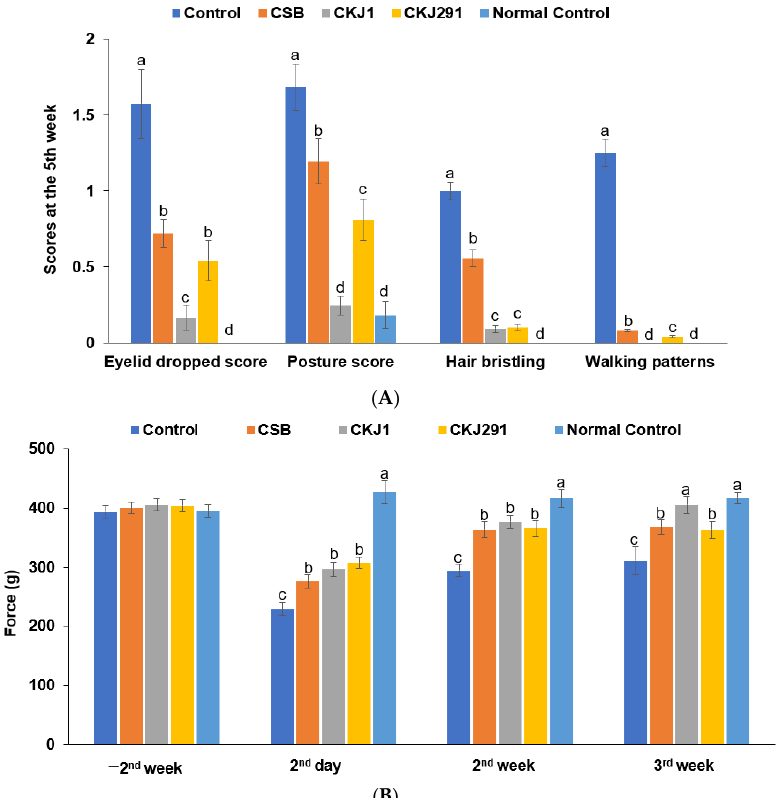
Figure 3. Neurological severity scores. The neurological symptoms, including drooping eyelids, crouched posture, bristling hair, flexor reflex and walking patterns ( A ), and force to grip the bar ( B ), were shown on the 2nd day, 2nd week, and 3rd week after inducing an ischemic stroke. Bars represent means ± SD ( n = 10). a,b,c,d Means on the bars with different letters were significantly different by Tukey’s test at p < 0.05. Table 3. Proinflammatory cytokines in the blood and hippocampus on the 3rd week after artery occlusion.